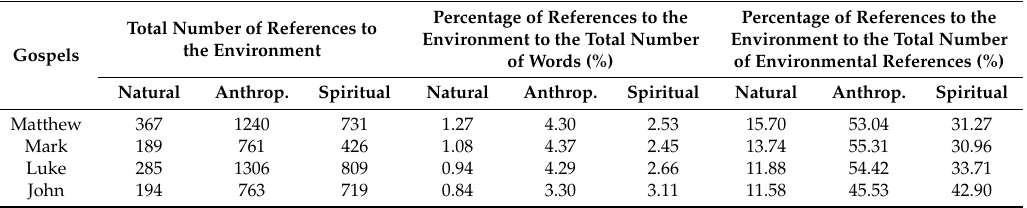
Table 2. Environmental references of the General Environmental